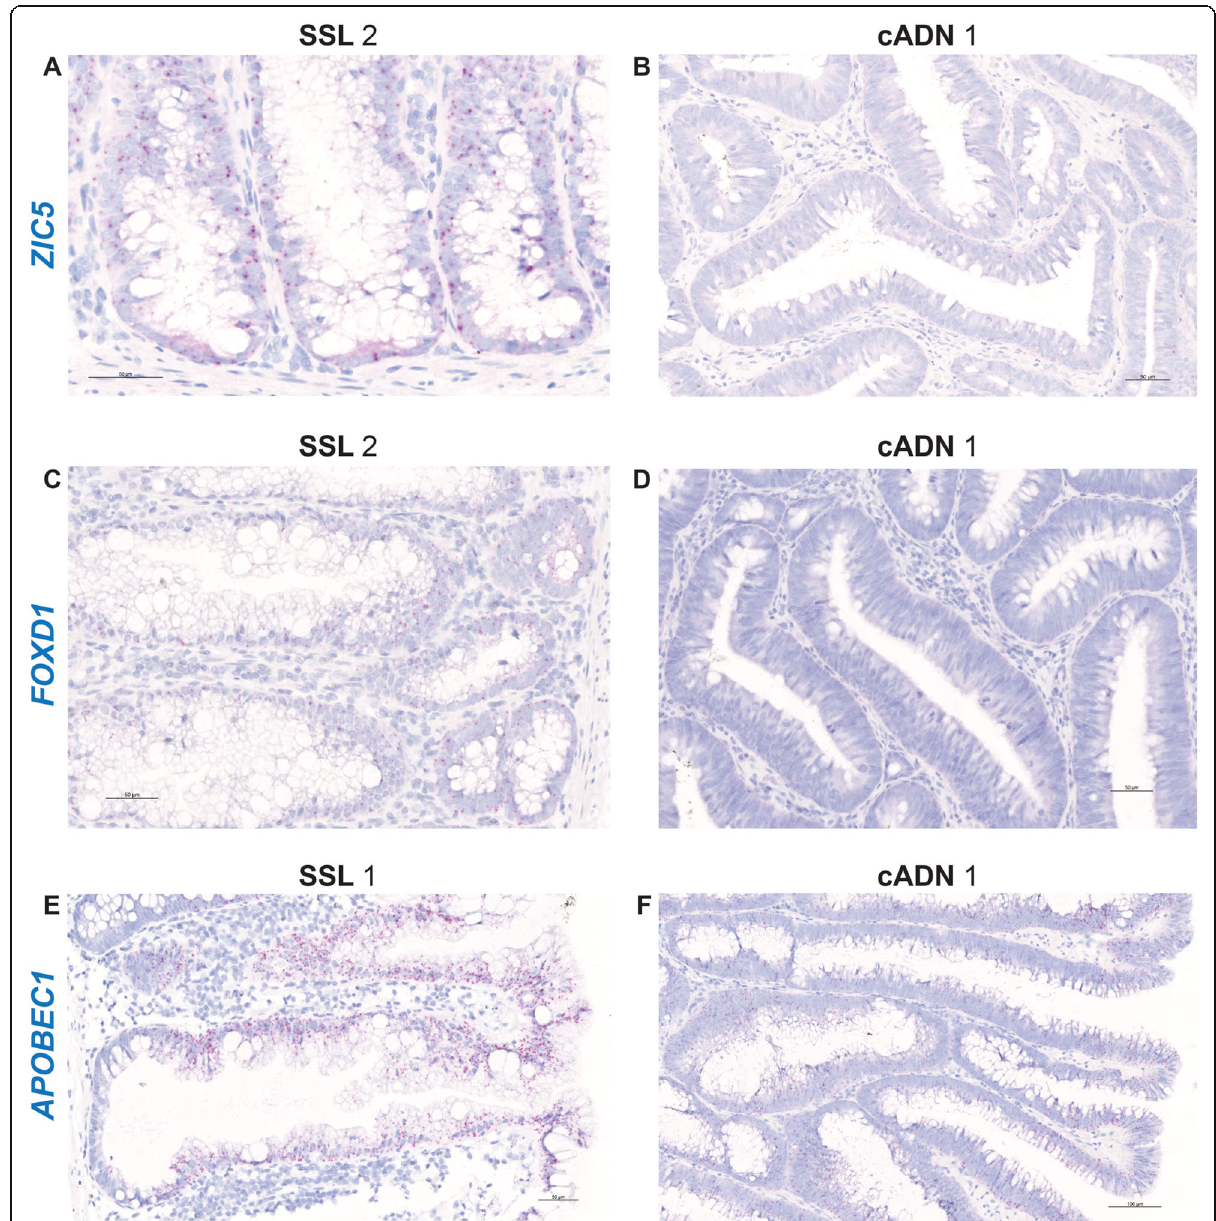
Fig. 4 In situ hybridization analysis of ZIC5 , FOXD1, and APOBEC1 mRNAs in SSLs and cADNs. While ZIC5 and FOXD1 are expressed in SSLs but not in cADNs, APOBEC1 is moderately expressed in cADNs (superficially or irregularly) albeit less abundantly than in SSLs. Details on the expression patterns of these three RNAs in the investigated lesions and in normal mucosa are shown in Supplementary Figs. 10, 11, and 12, and summarized in Table